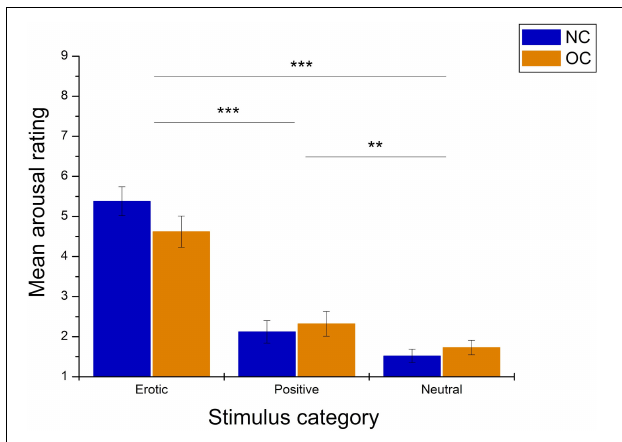
FIGURE 4 | Mean valence ratings in reaction to erotic, positive and neutral stimuli in NC women and OC users. Error bars reflect SEM. *** p <